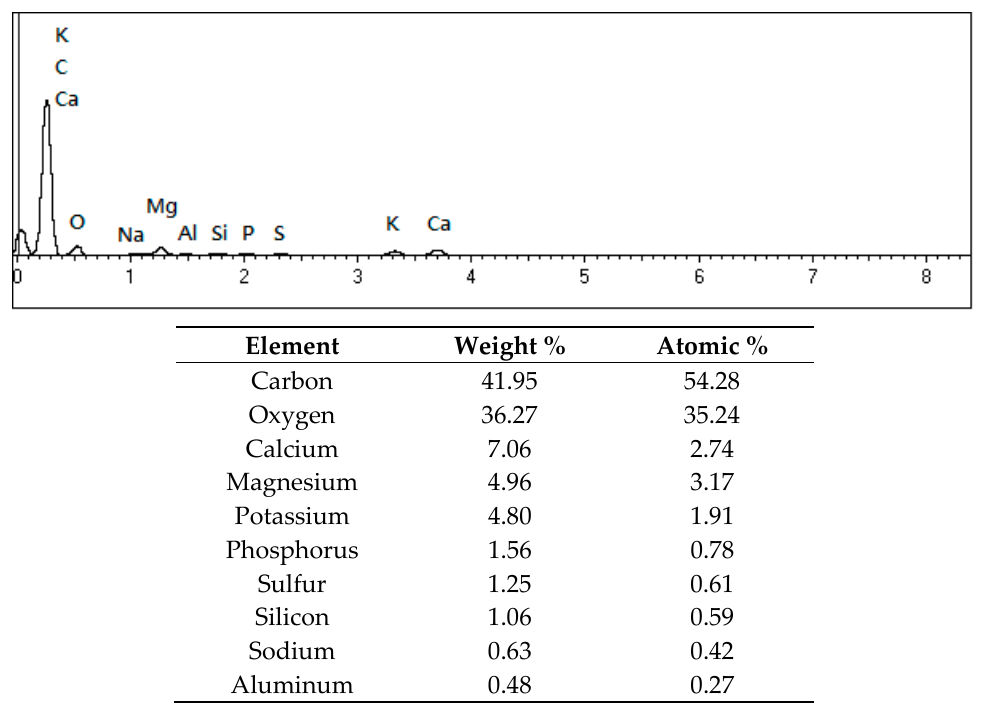
Figure 3. EDS analysis of DM-BC.